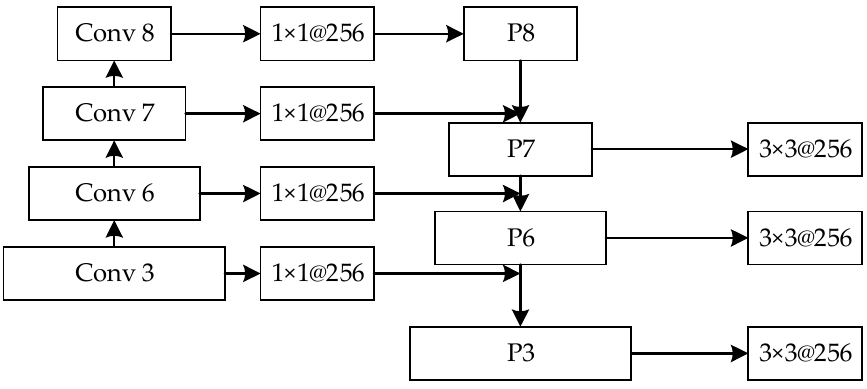
Figure 6. Characteristic pyramid network connection mode diagram.